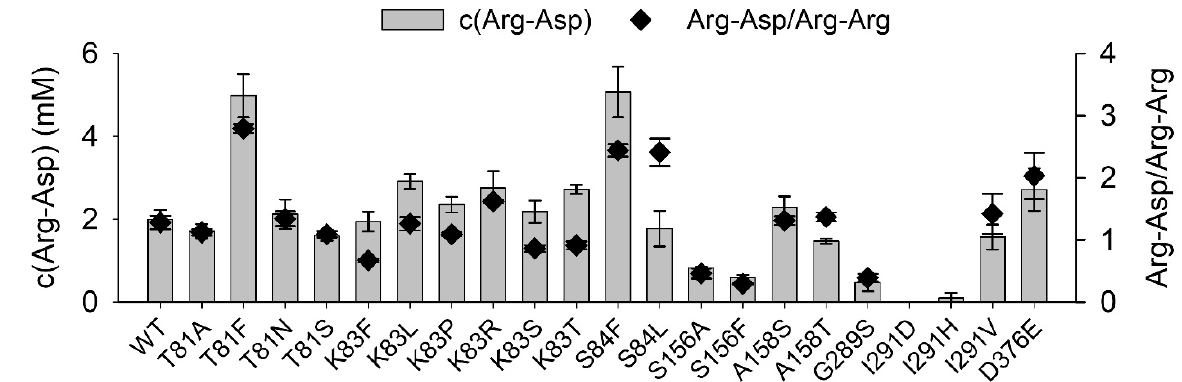
Figure 5. Formation of Arg-Asp and Arg-Arg by the RizA variants. 30 mM of both arginine and aspartic acid and 20 h reaction time at 25 °C. Reactions were set up in triplicates and data is presented as mean ± standard deviation.